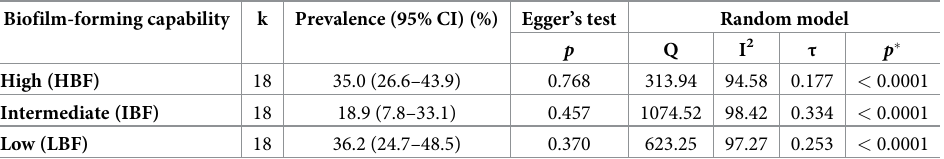
Table 5. Overall effects in subgroups based on biofilm-forming capability.